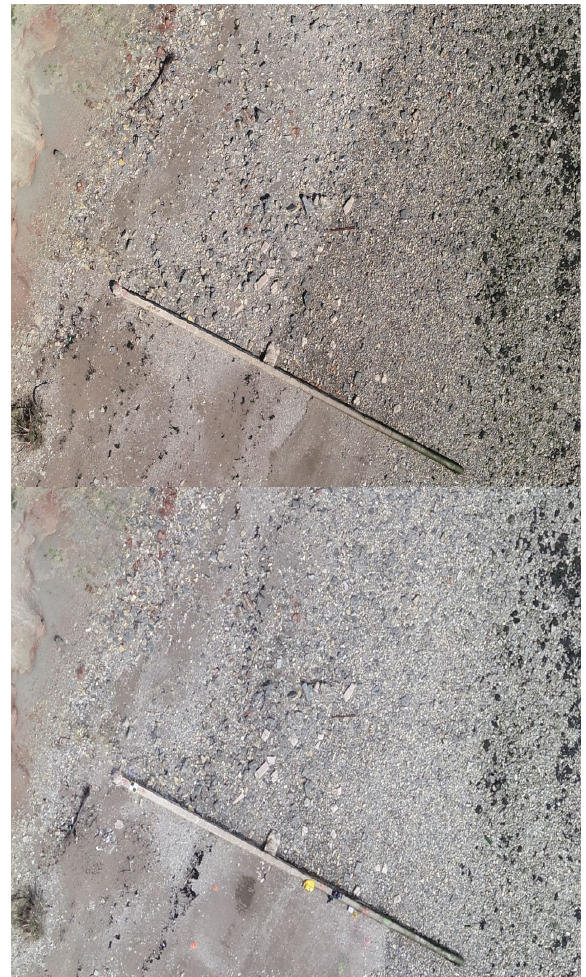
Figure 15 - UAV Orthomosaic for Penarth - Top: 31 st July 2020 Bottom: 2 nd August 2020.